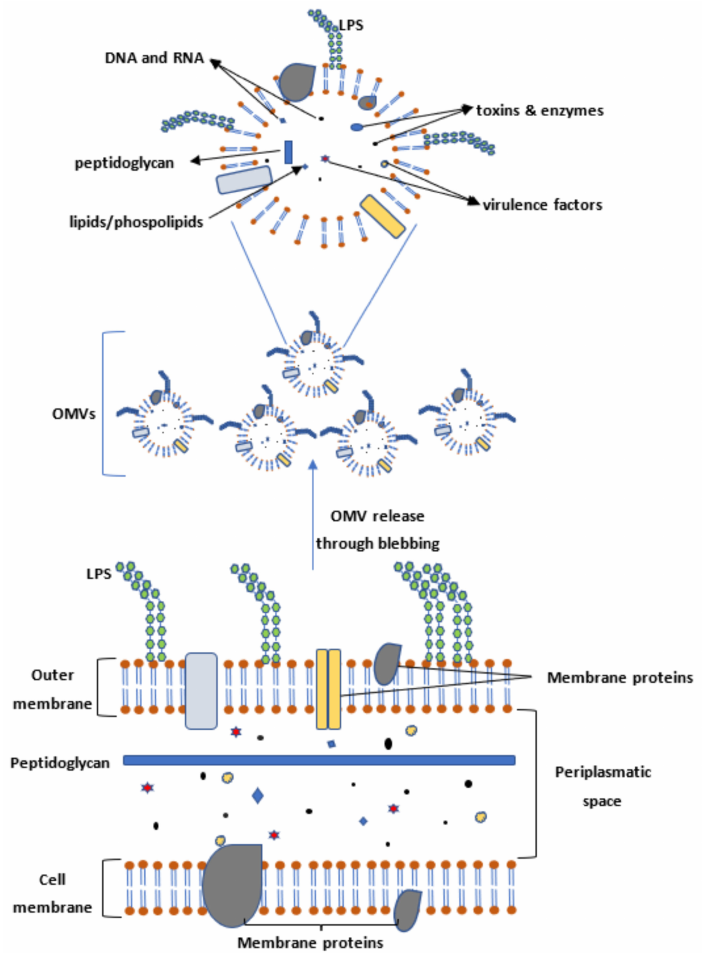
Figure 1. OMVs originate from the outer membranes of Gram-negative bacteria. They are 50–300 nm large vesicles that contain lipids, proteins, phospholipids, peptidoglycan, toxins, enzymes, LPS, DNA, and RNA derived from the periplasm between the inner membrane and the outer membrane as well as from the inner and outer membranes